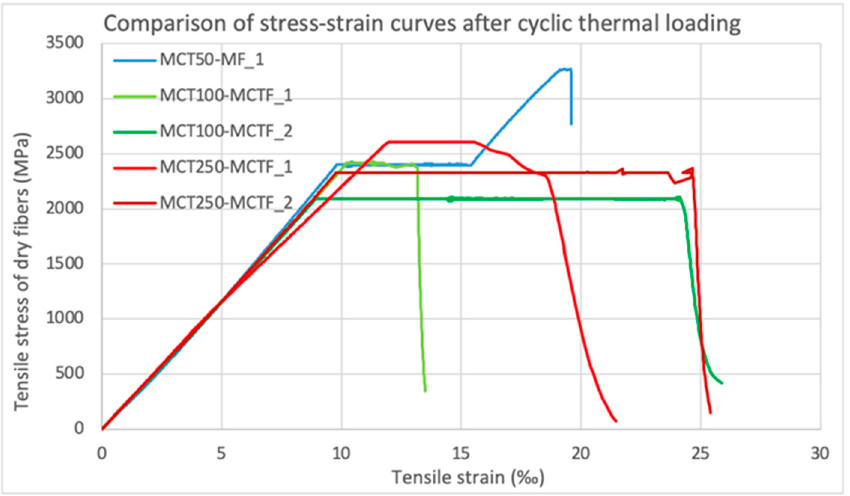
Figure 12. Stress–strain curves for low cycle thermal loading under constant tensile load. The maximum temperatures of the cycles were 50, 100 and 250 °C.